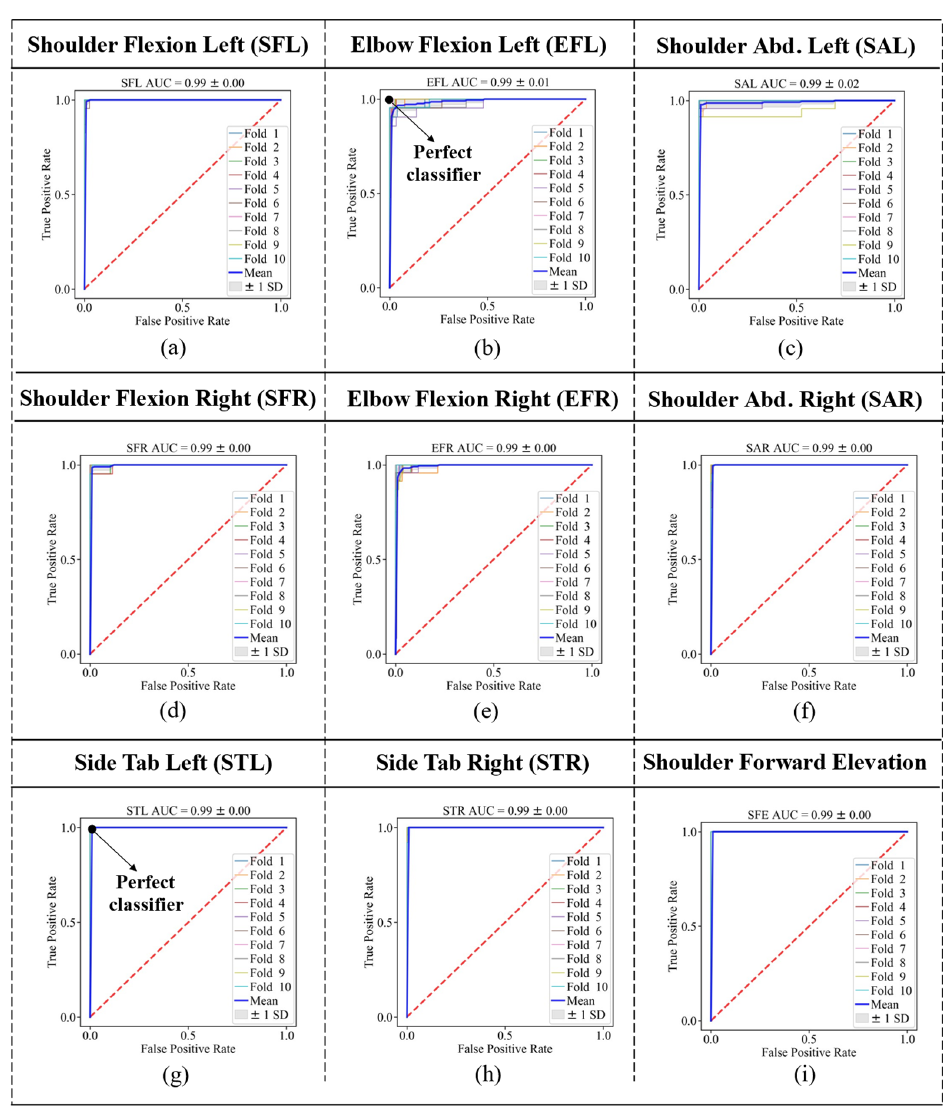
Figure 5. ROC curves considering 10-Fold cross validation for gestures ( a ) SFL, ( b ) EFL, ( c ) SAL, ( d ) SFR, ( e ) EFR, ( f ) SAR, ( g ) STL, ( h ) STR, and ( i ) SFE. The bold blue line in each graph shows the average of all 10 folds for that specific gesture. This figure also confirmed that the two lower limb exercises, STL and STR, pro- vided the best ROC curves (perfect classifier); however, the EFL and EFR provided maxi- mum distances to the perfect classifier (0,1), as shown in Figure 6c. The average ROC AUC achieved was 0.99 considering all gestures.